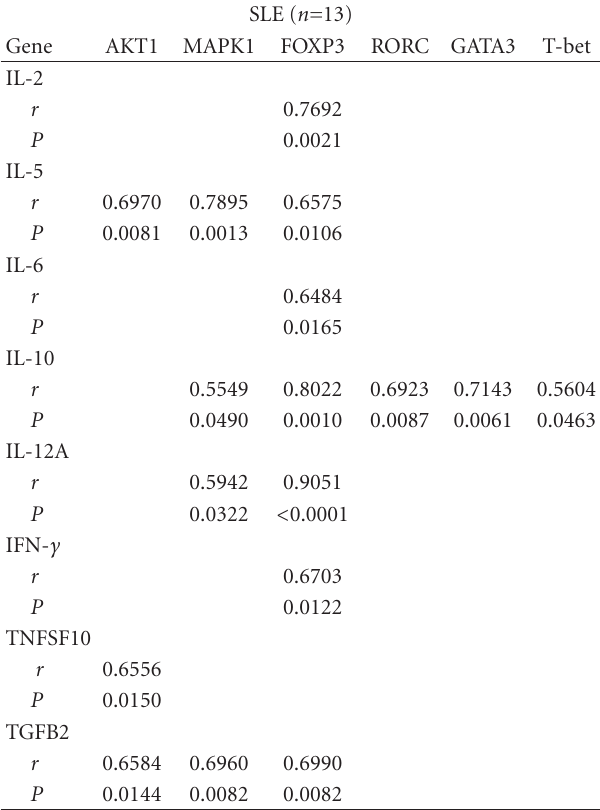
Table 6: Spearman’s rank correlations found between MAPK1, AKT1, and Th-transcription factors gene expressions in SLE patients.